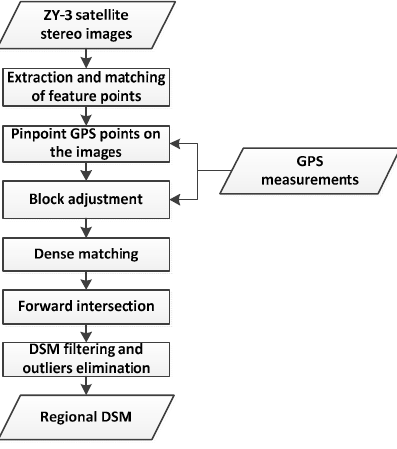
Figure 4. The flowchart of DSM derived from ZY-3 stereo images.